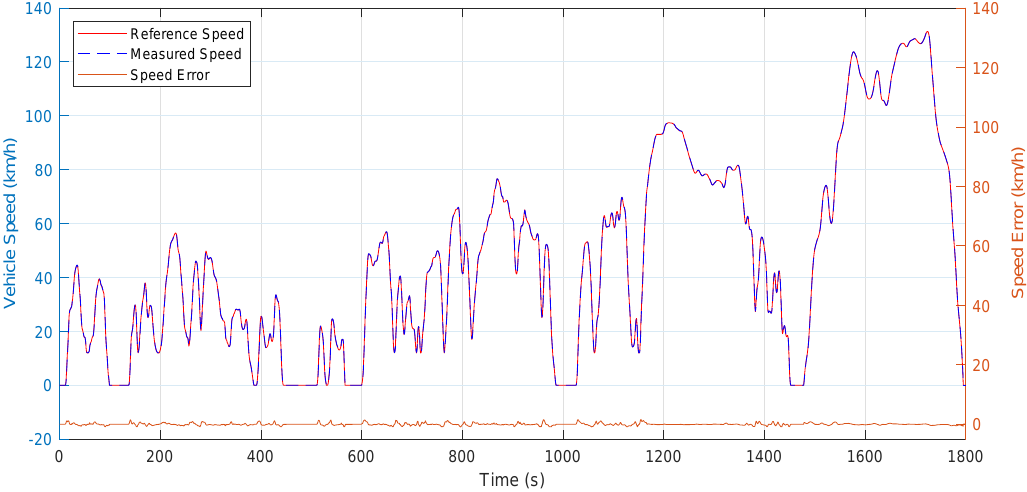
Figure 13. Vehicle reference speed, measured speed, and speed error (with example EMS).